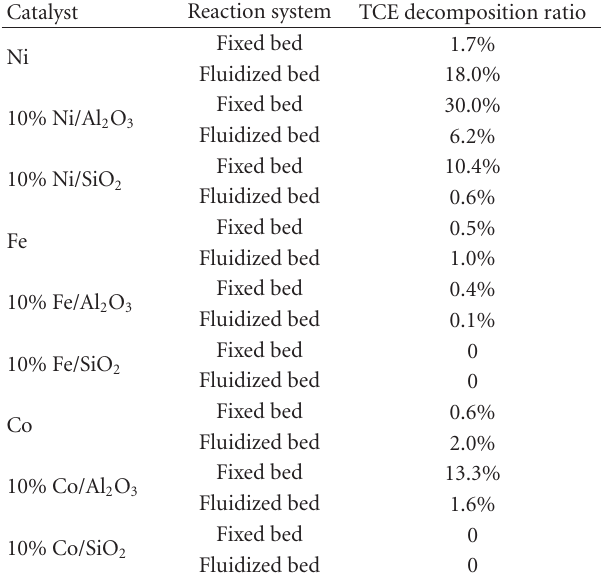
Table 1: TCE decomposing results over di ff erent catalysts and di ff erent reactor